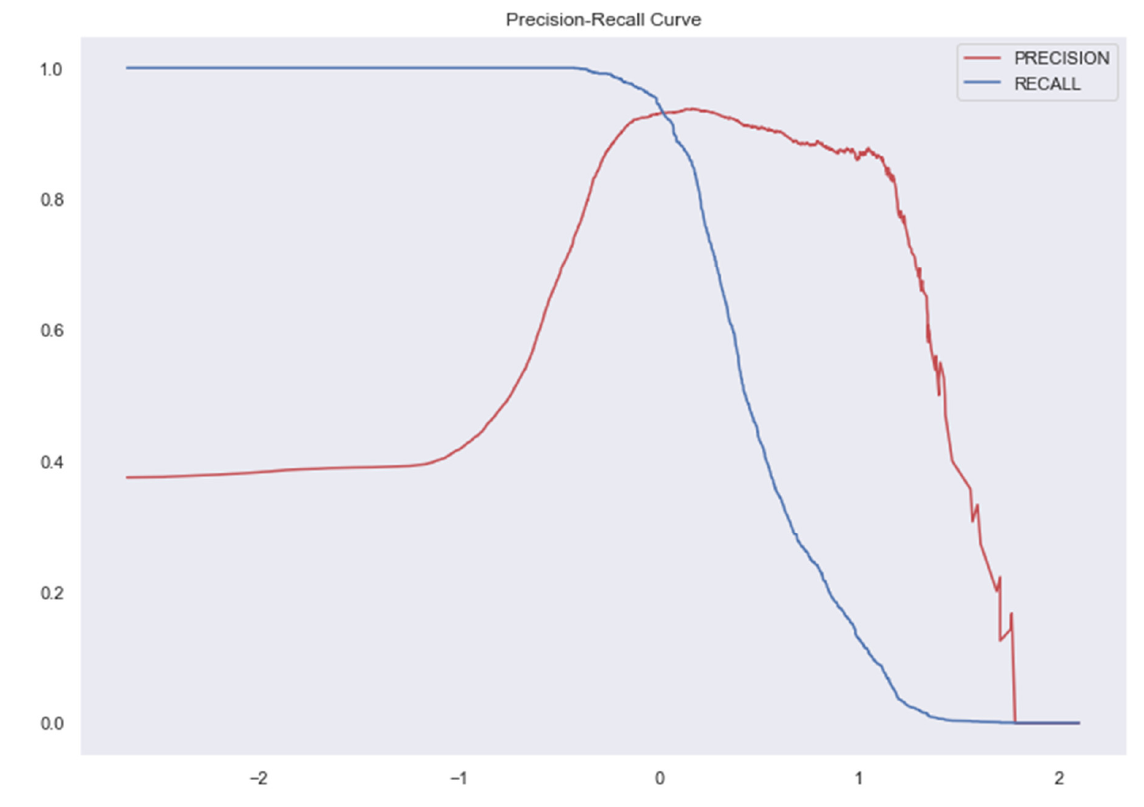
Figure 11. AUC and Precision-Recall Curve for KNN.